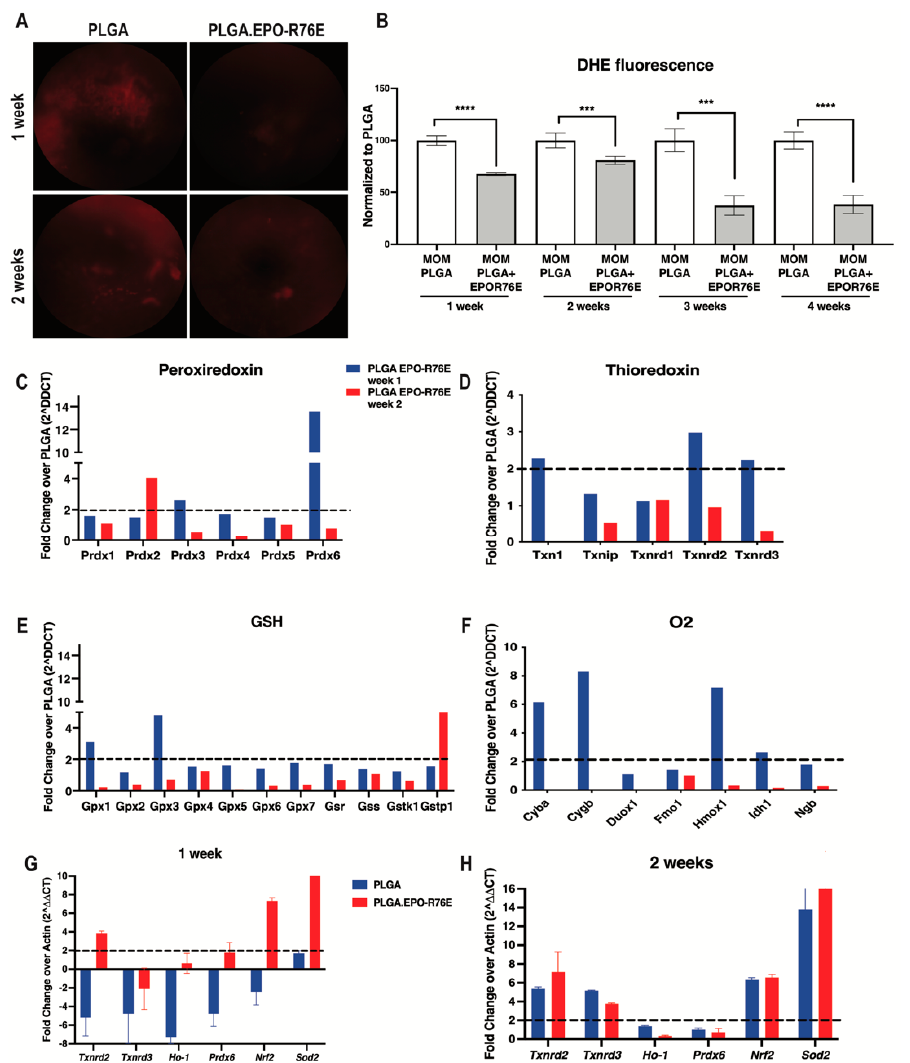
Figure 2. ( A ) Representative fundus images of DHE fluorescence at 1 and 2 weeks post-IOP eleva- tion in empty PLGA controls and PLGA.EPO-R76E injected mice. ( B ) Quantification of DHE fluorescence at 1–4 weeks post-IOP elevation, *** p < 0.001, **** p < 0.0001. ( C – F ) Quantification of peroxiredoxin-related genes, thioredoxin-related genes, glutathione-related genes and oxygen-related genes shown as fold change over PLGA at 1 and 2 weeks post-IOP elevtaion, respectively. ( G , H ) Quantification of antioxidant gene transcription shown as fold change over PLGA at 1 and 2 weeks post-IOP elevation, respectively.